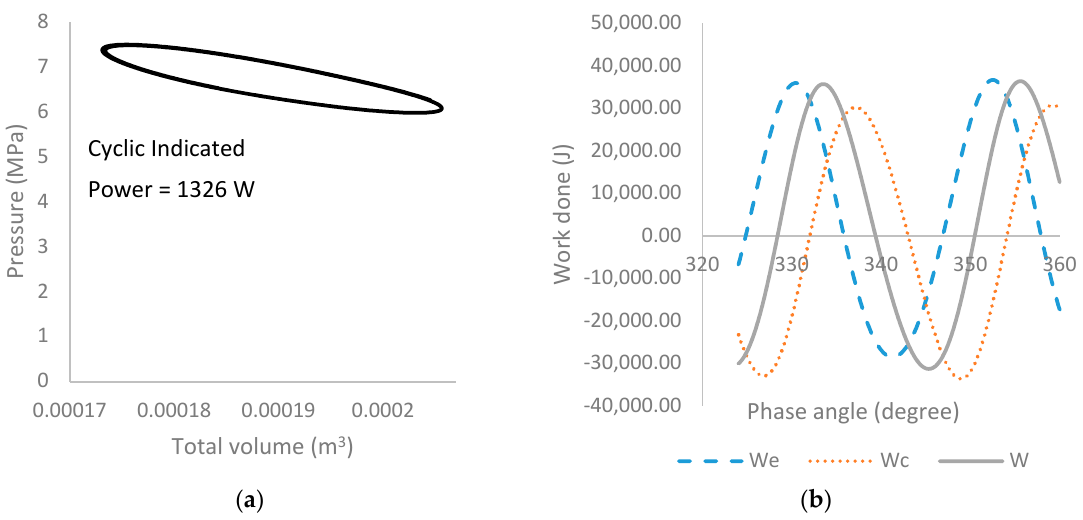
Figure 8. ( a ) Pressure-to-volume diagram of the optimal solution of the FPSE; ( b ) Work done in the optimal solution of the FPSE.